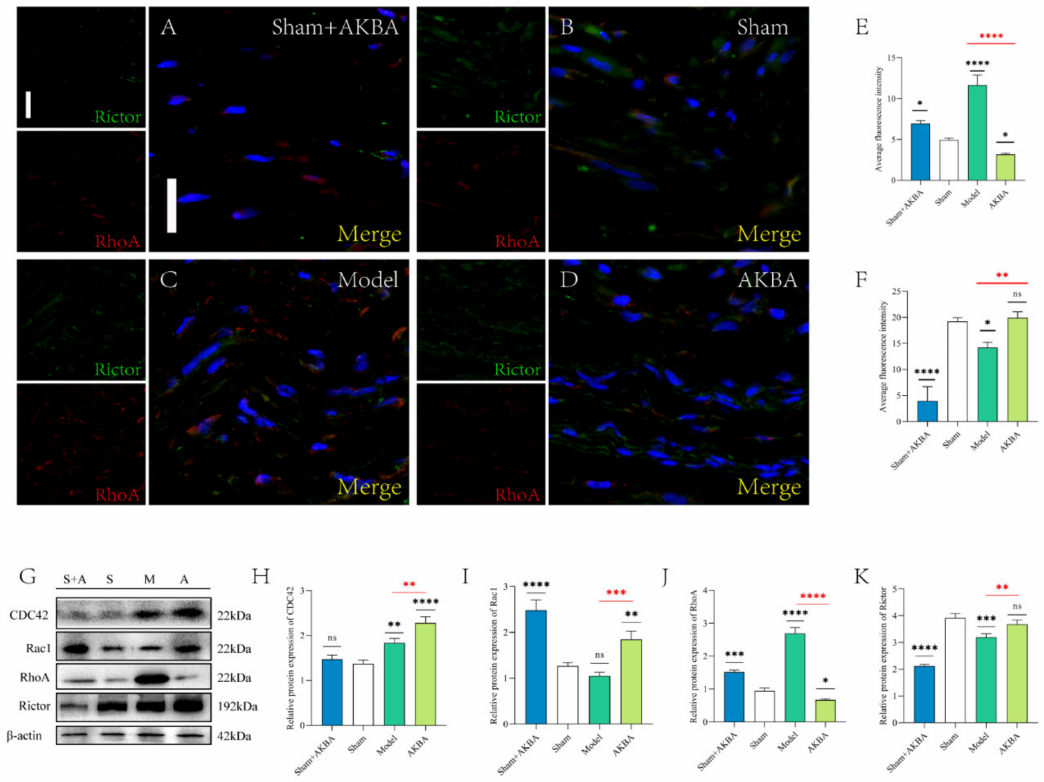
Figure 5. Protein changes in the injured sciatic nerve after 14 d of AKBA intervention. ( A – D ) Immunofluorescence staining plots of RhoA and Rictor in each group. The scale bar of the images is 20 µ m. ( E – F ) Quantification of the mean fluorescence intensity of RhoA and Rictor. ( G )